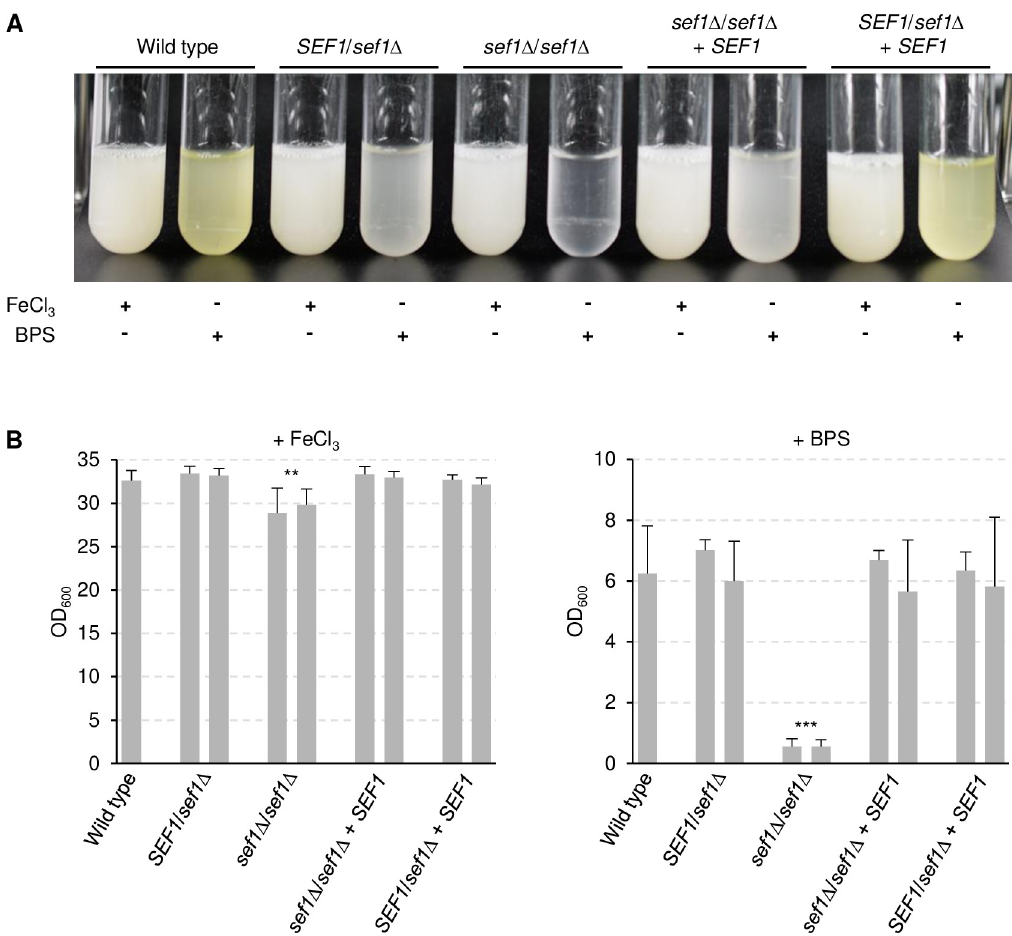
Fig 2. Sef1 is required for growth and riboflavin secretion in iron-depleted medium. (A) The wild-type strain SC5314, heterozygous and homozygous sef1 Δ mutants, and complemented strains in which a wild-type SEF1 copy was reinserted into the homozygous ( sef1 Δ / sef1 Δ + SEF1 ) or heterozygous ( SEF1 / sef1 Δ + SEF1 ) mutants were grown in minimal medium with (+ FeCl 3 ) or without iron (+ BPS). Cultures were photographed after 4 days of growth at 30˚C. The two independently generated series of strains behaved identically and only one of them is shown. (B) The optical densities of the cultures were determined; shown are the means and standard deviations of three independent cultures of each strain. Results for both independently generated series of strains are shown separately; data were combined for statistical analysis. Significant differences from the wild type are indicated by stars ( ��� , p < 0.001; �� , p <